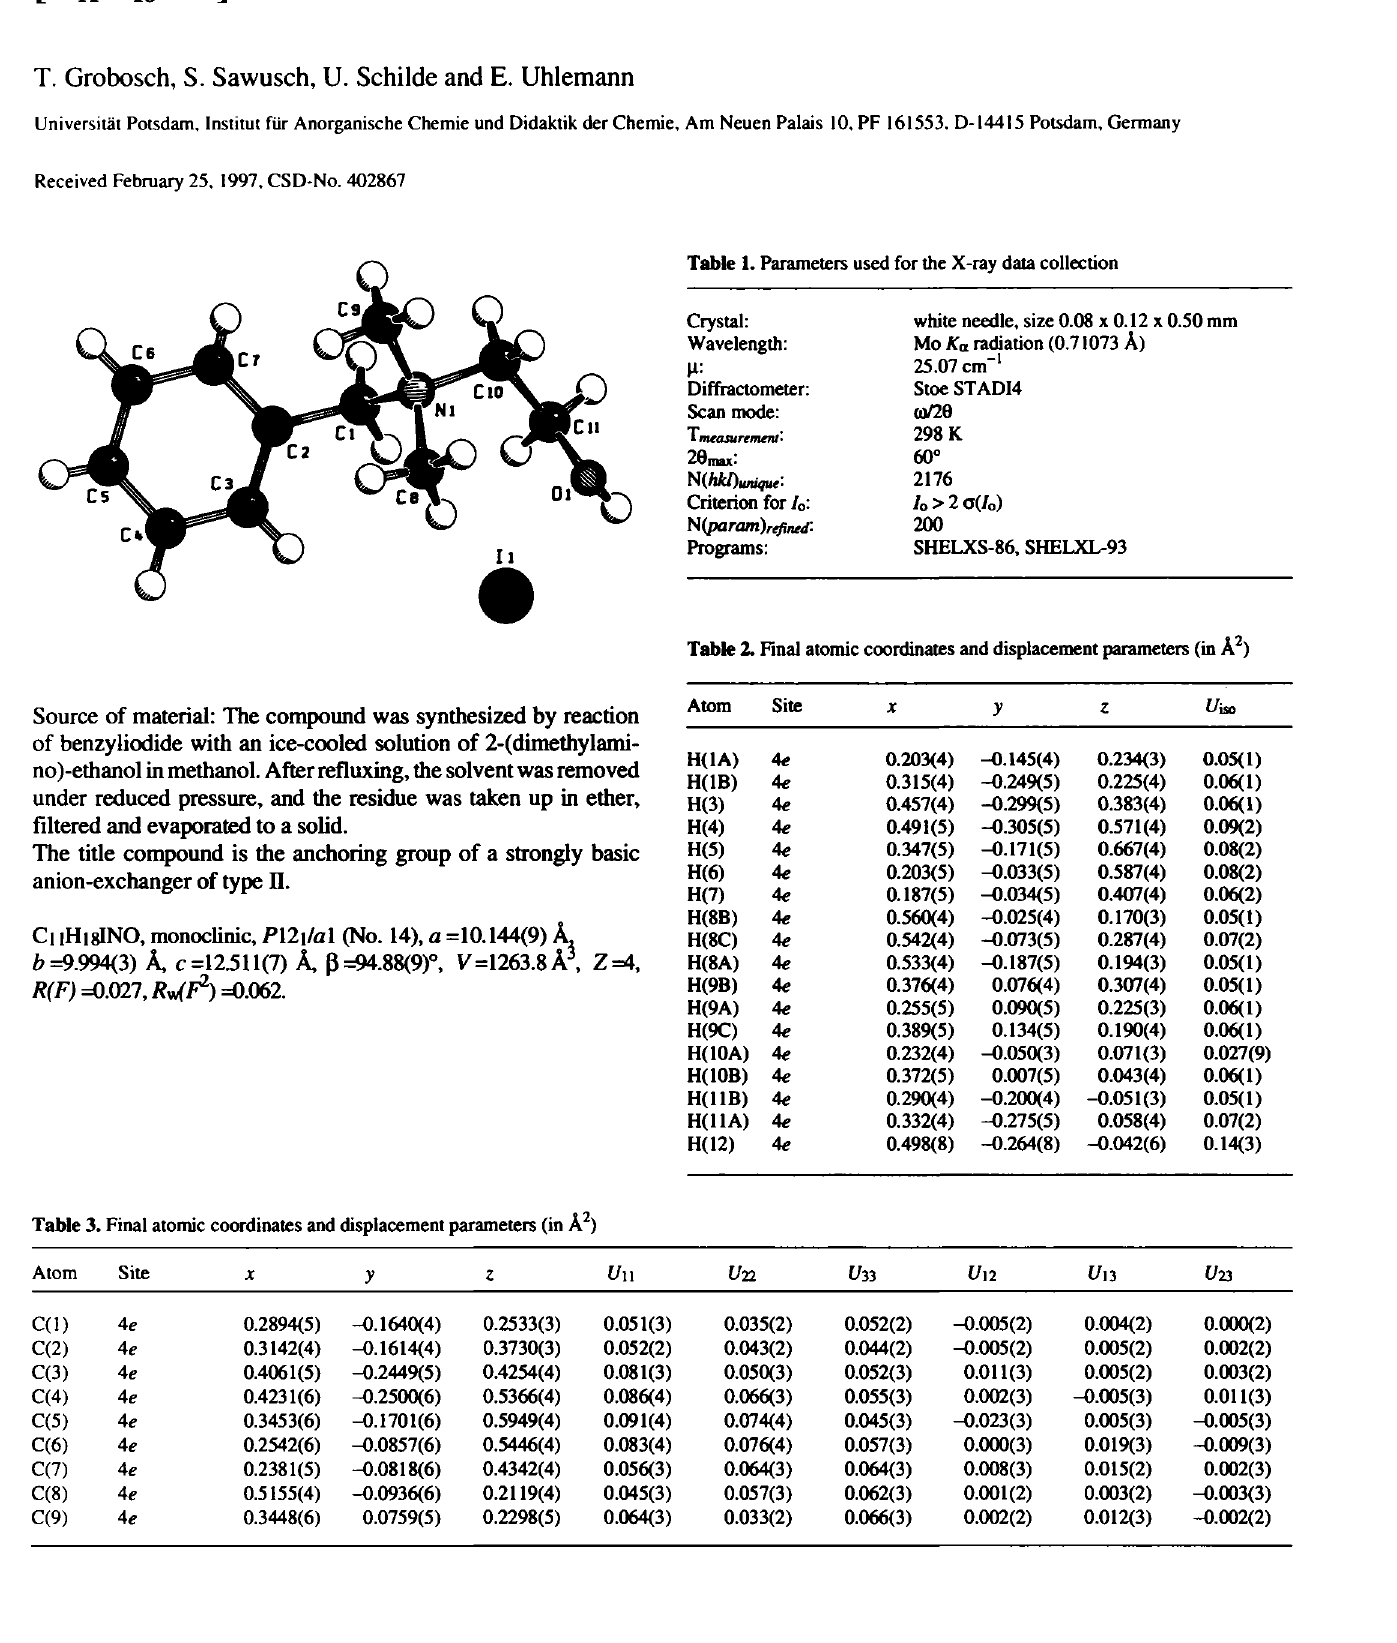
Table 3. Final atomic coordinates and displacement parameters (in Â^)